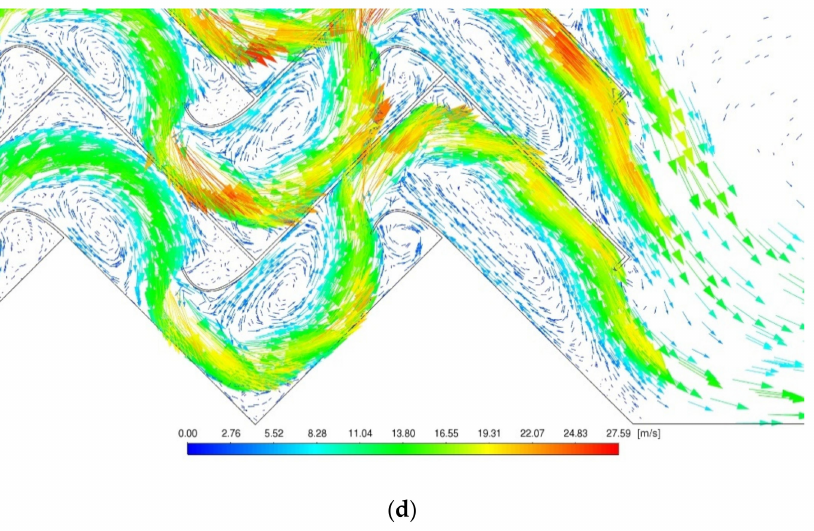
Figure 19. Velocity fields (m s − 1 ) of geometry variant C_15_0 with streamline drainage channels with inlet velocities ( a , b ) 2 m s − 1 and ( c , d ) 4 m s − 1 , which were simulated using a transition SST model. Velocity fields ( a , c ) (m s − 1 ) and vectors ( b , d ) (m s − 1 ) of geometry variant C_15_0 with streamline drainage channels with inlet velocities ( a , b ) 2 m s − 1 and ( c , d ) 4 m s − 1 , which were simulated using a